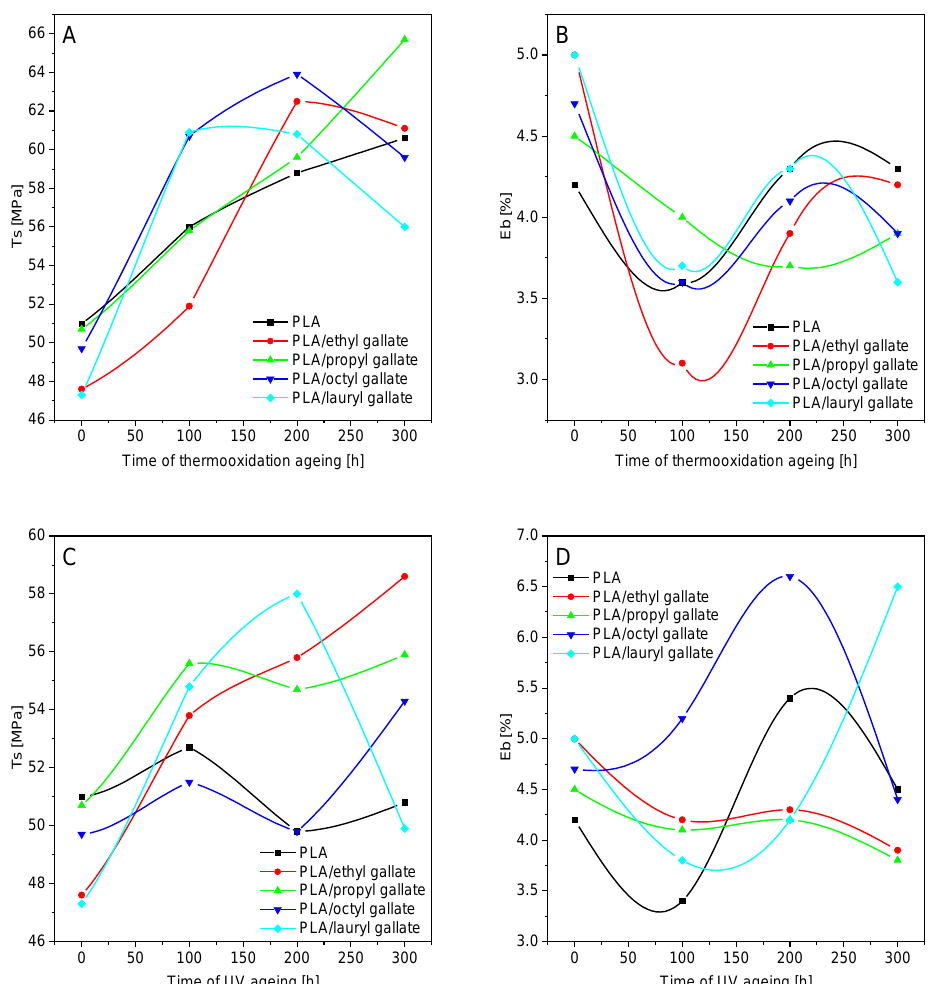
Figure 7. Changes in PLA mechanical properties ( T s : tensile strength and E b : elongation at break) before and after thermooxidation ( A , B ) and UV aging ( C , D ).